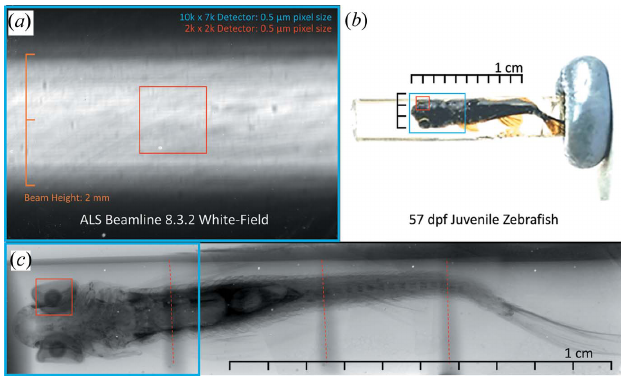
Figure 2 Field-of-view characterization utilizing the ALS synchrotron beam and large-scale biological sample. The entirety of the beam height at the ALS 8.3.2 beamline is encapsulated by the detector’s field of view while maintaining 0.5 m m pixel size ( a ). A 2000 (cid:2) 2000 pixel field of view at the same 0.5 m m pixel size is shown in red. To illustrate the field of view in a more biologically applicable and practical sense, we present a cm-scale, juvenile, 57 day post-fertilization (d.p.f.) zebrafish embedded in resin and stained with phosphotungstic acid (PTA) ( b ) using a local NOVA 96000 tungsten filament source to demonstrate field of view ( c ), with coverage of the same 2000 (cid:2) 2000 pixel array in red and our detector’s field of view in blue. Rotating the camera by 90 (cid:5) makes it possible to scan in a single view horizontally and to stitch in four sections vertically, compared with approximately 500 scans on a 2000 (cid:2) 2000 detector to cover the same volume. Red dotted lines indicate areas of field-of-view